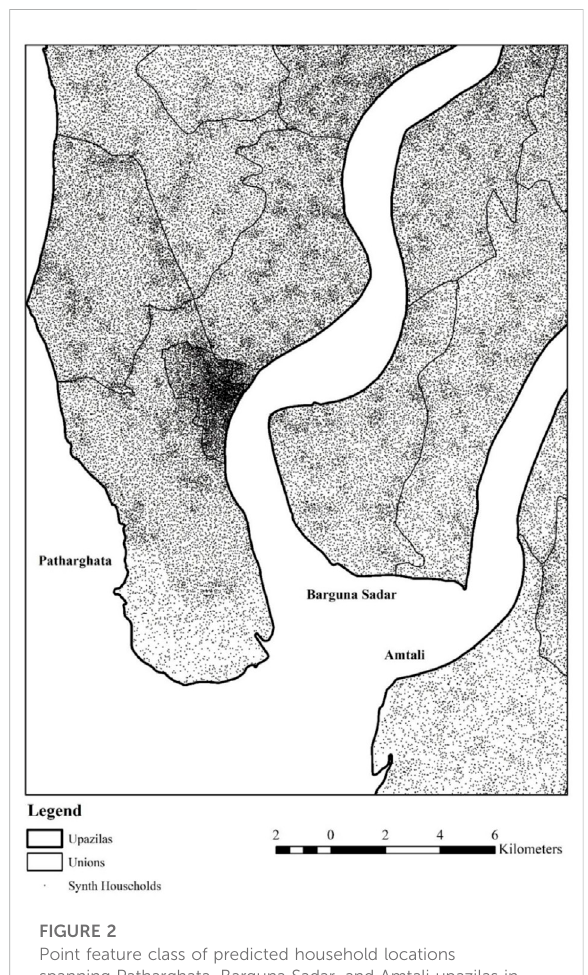
FIGURE 2 Point feature class of predicted household locations spanning Patharghata, Barguna Sadar, and Amtali upazilas in Barguna